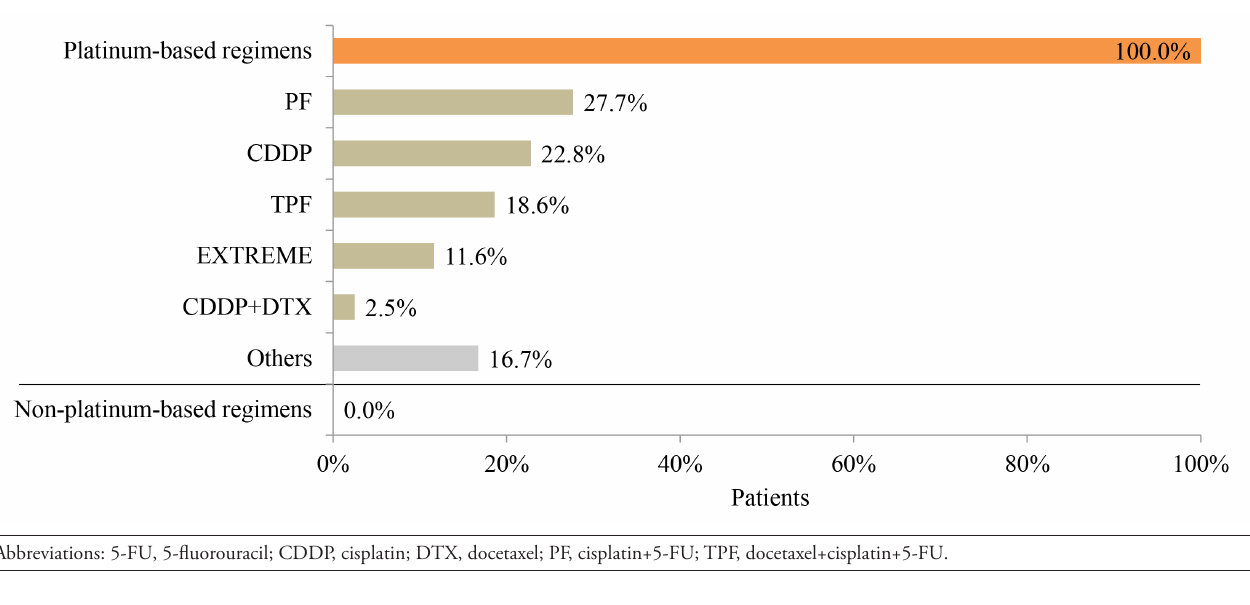
Figure 5. Previous Platinum-Containing Treatment for Platinum-Refractory Patients (N=842)